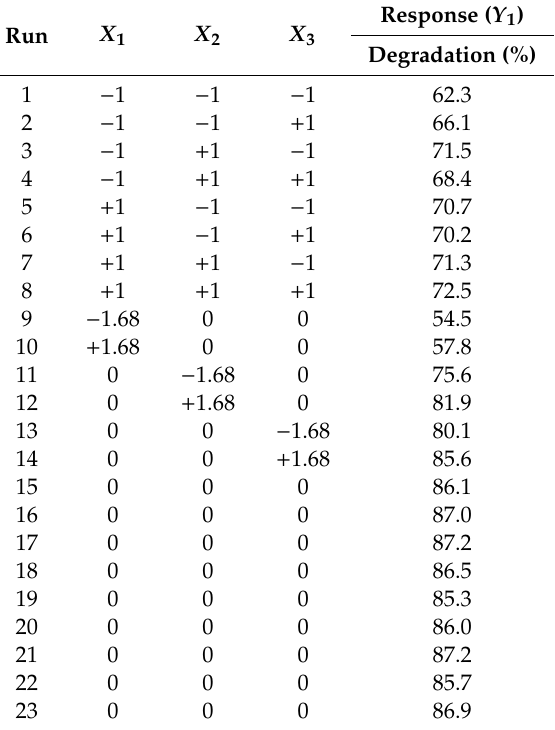
Table 2. Central composite rotatable design (CCRD) matrix and the response of the dependent variable for azoxystrobin degradation by strain SH14.